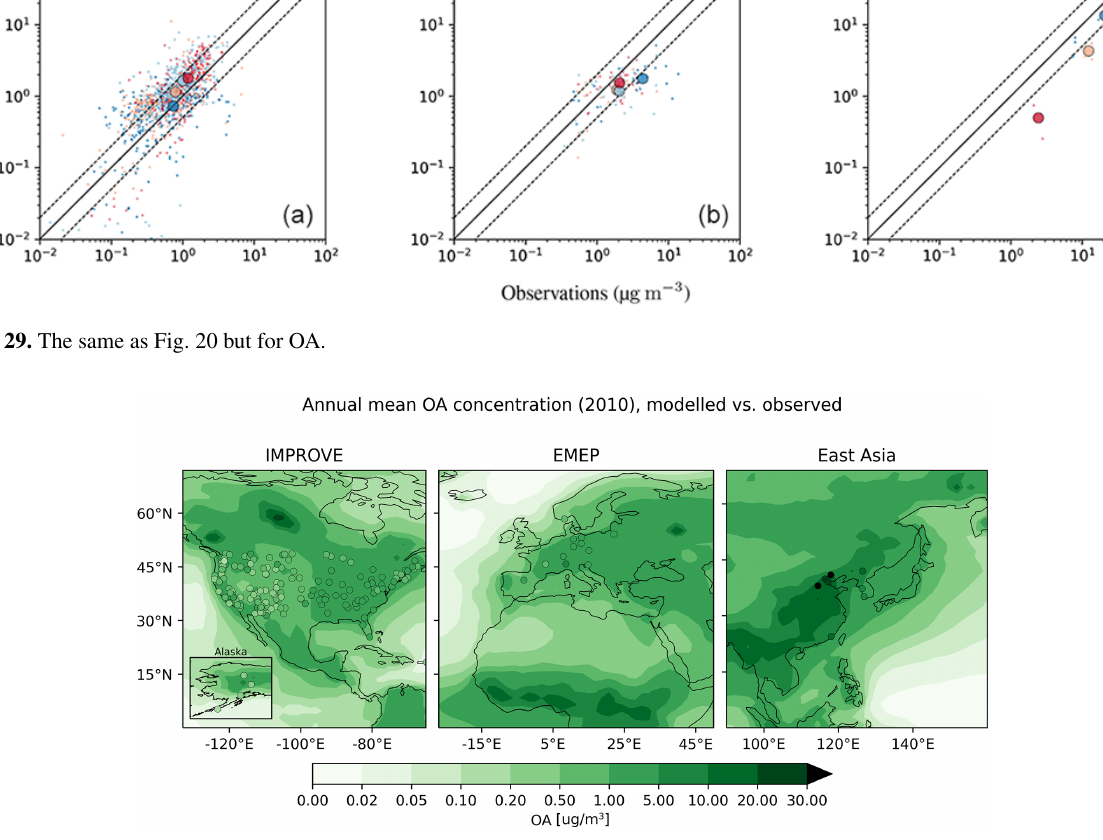
Figure 30. The same as Fig. 21 but for